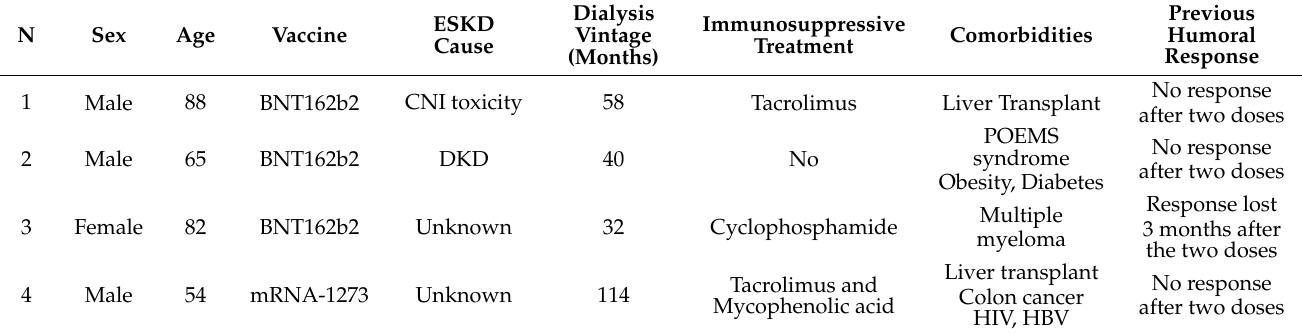
Table 1. Clinical characteristics of non-responders to three doses of SARS-CoV-2 mRNA vaccination.